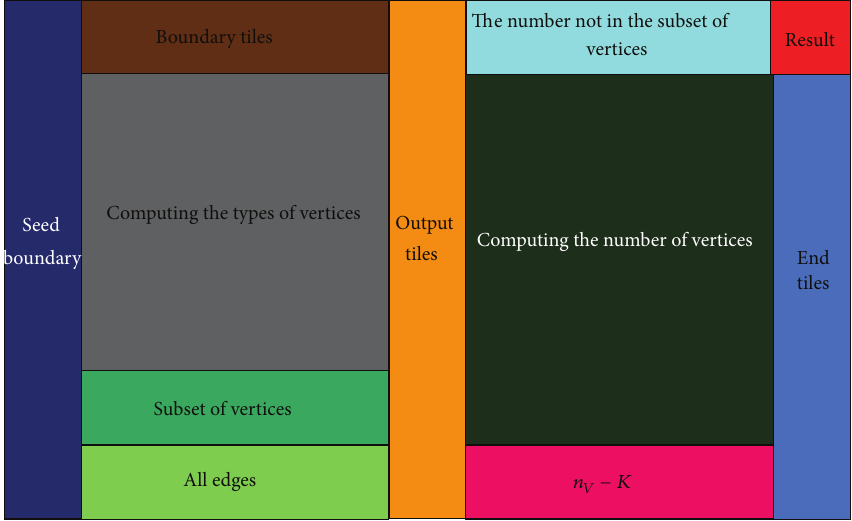
Figure 7: The construction of system SYS 𝐶 and the location of subsystems SYS V , SYS 𝑡 , and SYS 𝑘